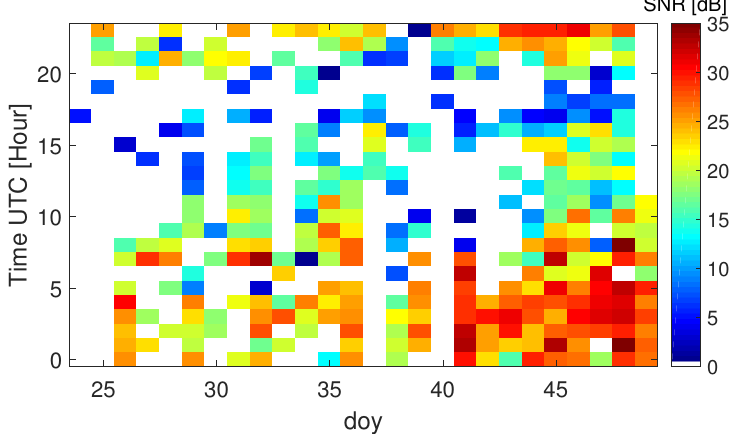
Figure 10. Maximum SNR measured in the wideband soundings for a given frequency as a function of the day of measurement (doy) and of the time of measurement for Campaign